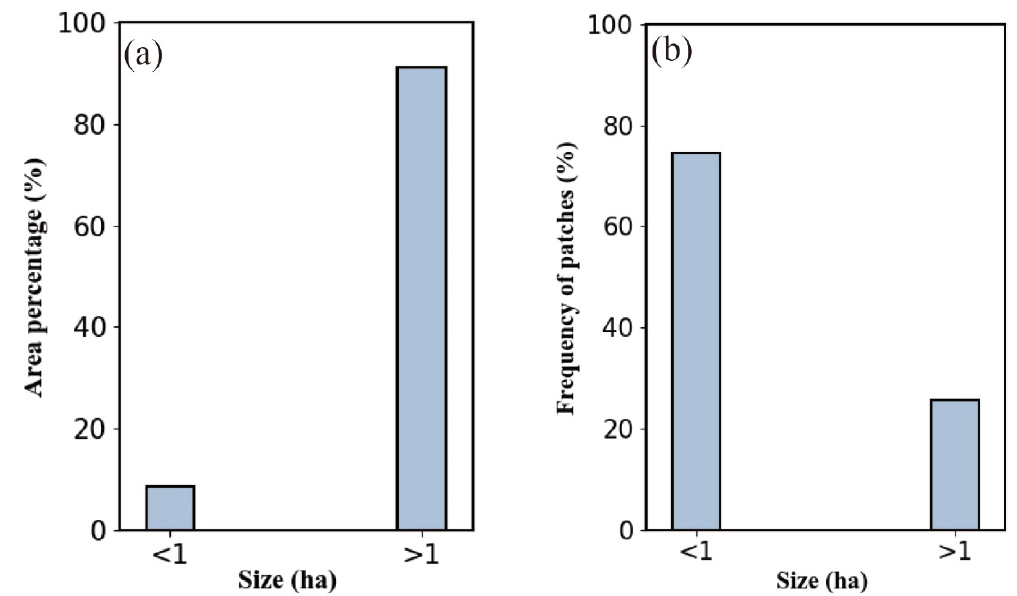
Figure 6. ( a ) The area percentage of mangrove patches with different size; ( b ) the frequency of mangrove patches with different size.